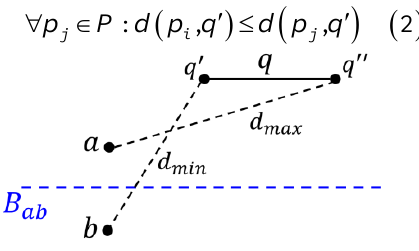
Figure 2. b is not NzNN of q, although it is reported in case that Minmax method is